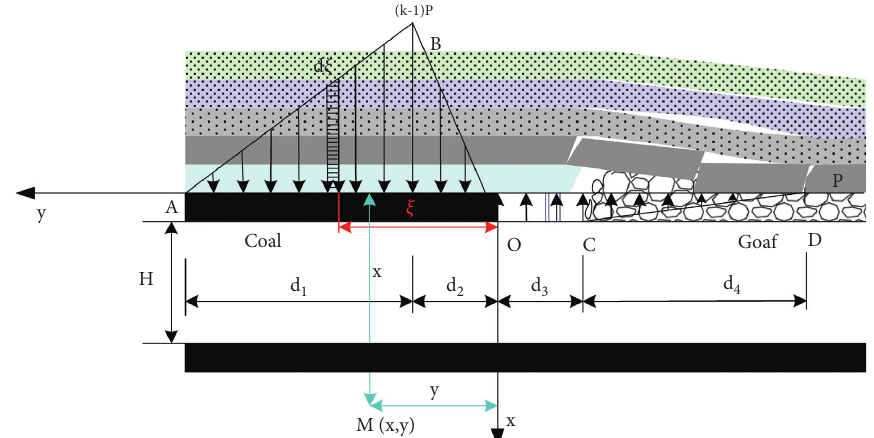
Figure 3: Simplified additional stress distribution graph before and behind the working face. P —vertical initial stress of rock, c H ; d from peak advanced abutment pressure to the abutment pressure falling within the initial stress zone of rock; d 2 —length from coal wall of the working face to the peak abutment pressure; d 3 —length of goaf with zero initial stress of rock; d 4 —length from residual abutment pressure in the goaf until the initial stress of rock is recovered; and H —interbed